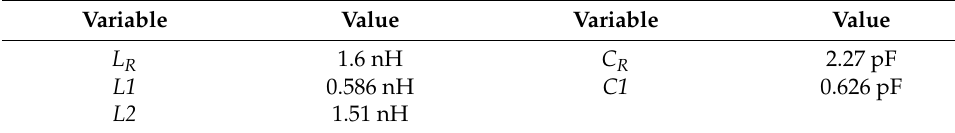
Table 3. The values of the circuit elements of the E − CRLH resonator.